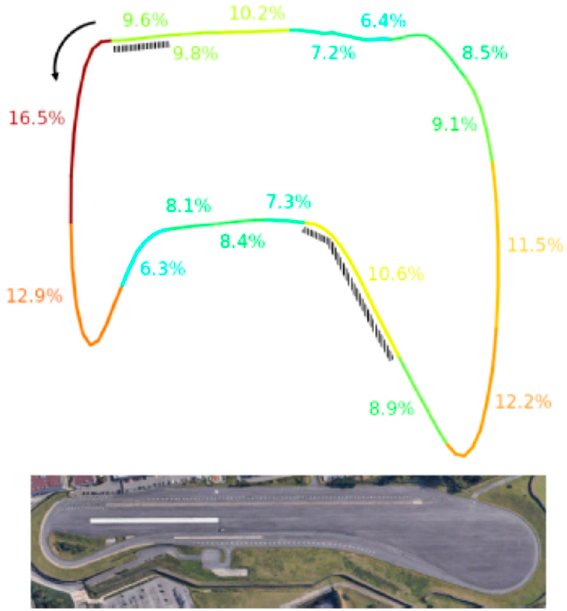
Figure 7. Epoch rejection rates of discarded trials in the different sections of the proving ground. The sections are color-coded based on the magnitude of the corresponding rejection rates. The arrow on the top-left corner indicates the driving direction, and the dashed markers highlight the lane-merging sections. The bottom aerial picture shows the real proportions of the proving ground.